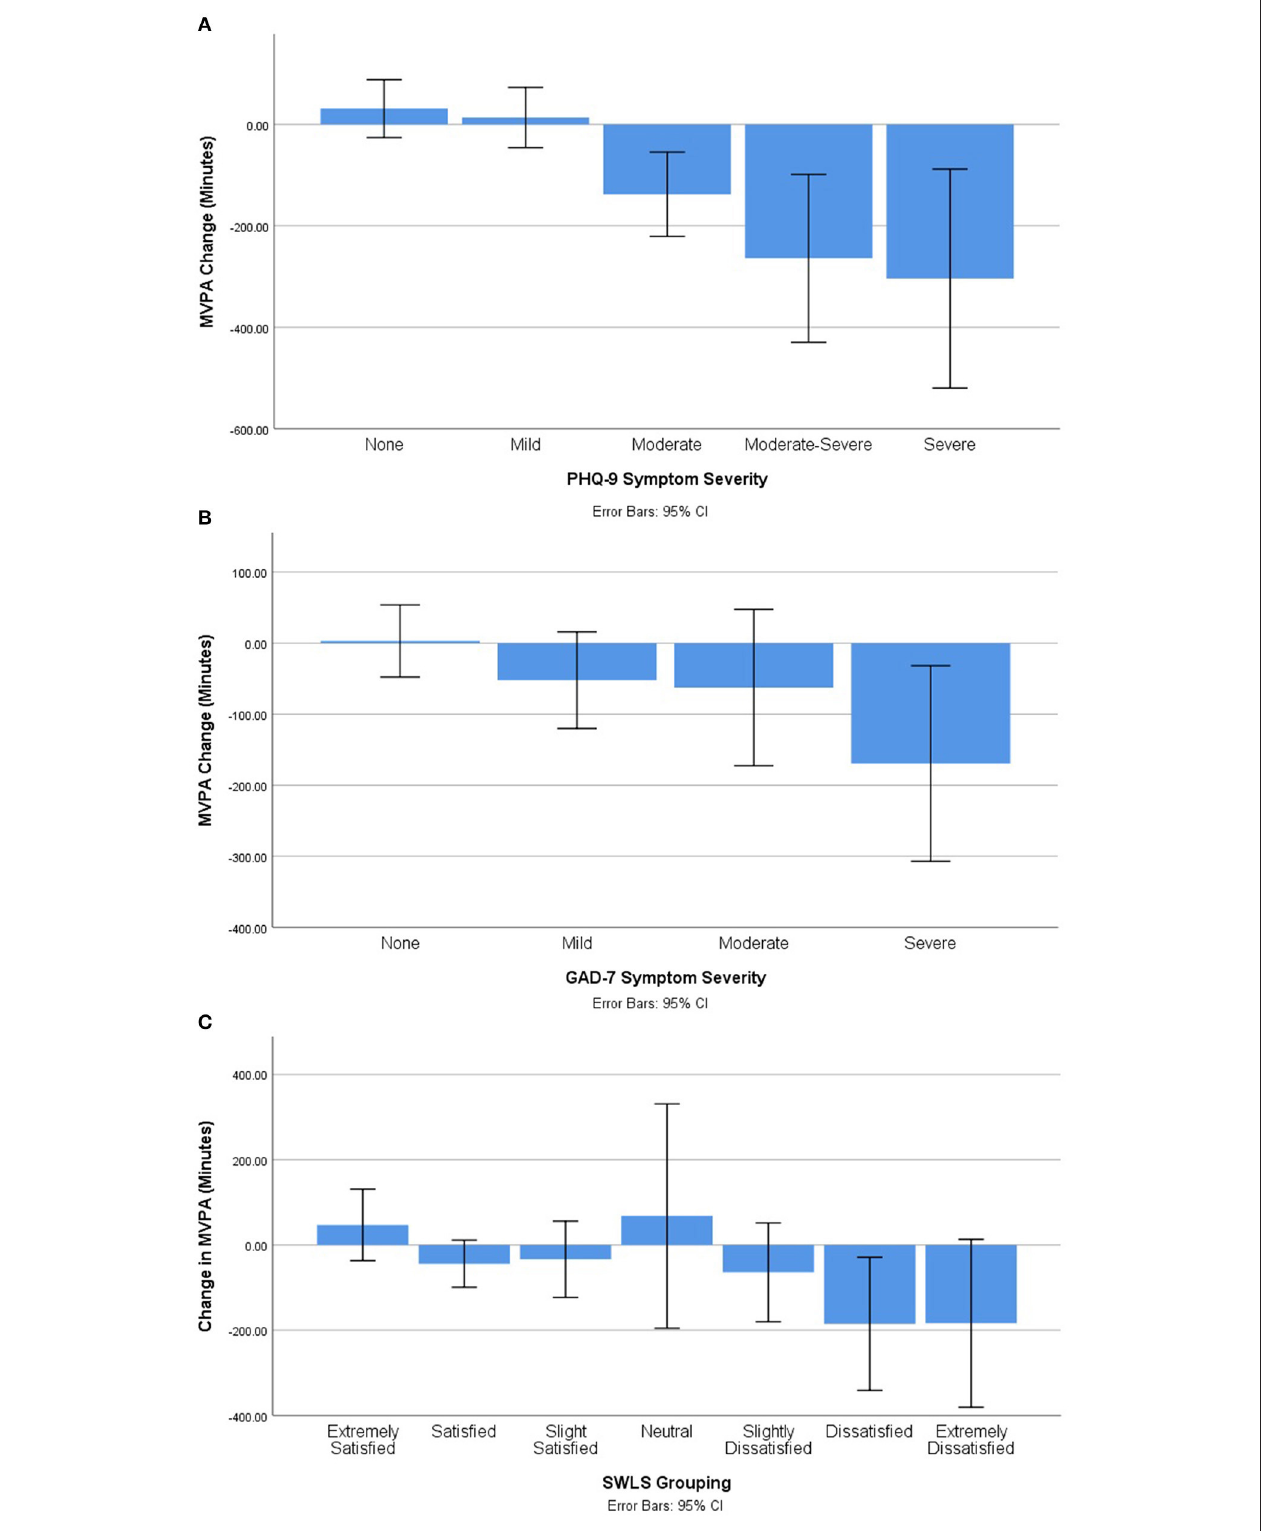
FIGURE 1 | Change in self-reported MVPA by mental health status. (A) Self-reported change in MVPA by depressive symptom severity. (B) Self-reported change in MVPA by anxiety symptom severity. (C) Self-reported change in MVPA by life satisfaction grouping.